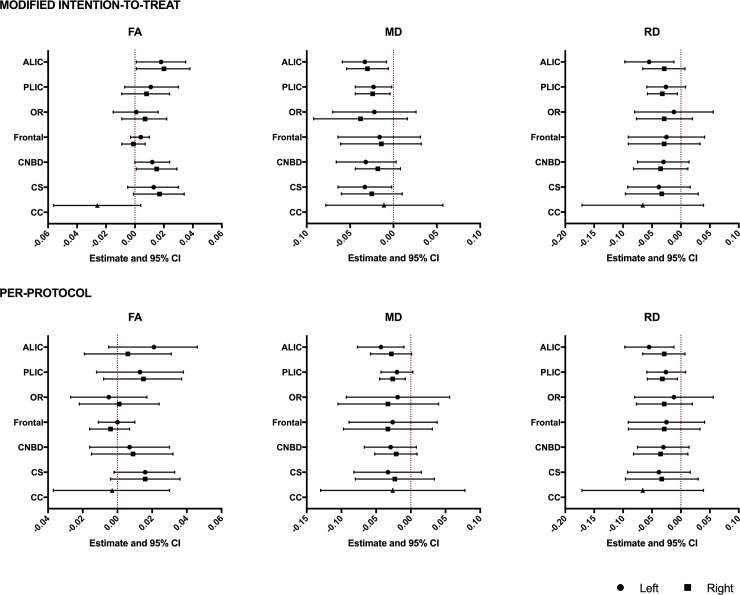
Relationships between maternal pomegranate juice intake and infant DTI measures.(Top) Treatment vs. placebo (modified intention-to-treat analysis). (Bottom) Metabolite-positive treatment vs. metabolite-negative placebo (per-protocol analysis). The point estimates represent the difference between groups in white matter DTI measures based on analyses run using generalized linear models (GLM) adjusted for postmenstrual age at scan. The error bars represent the 95% confidence intervals. ALIC–anterior limb of internal capsule; CC–corpus callosum; CNBD–cingulum bundle; CSOV–centrum semiovale; FA–fractional anisotropy; Frontal–frontal lobe; OR–optic radiation; MD–mean diffusivity; PLIC–posterior limb of internal capsule; RD–radial diffusivity. Left/Right indicate measures for bilateral white matter tracts.